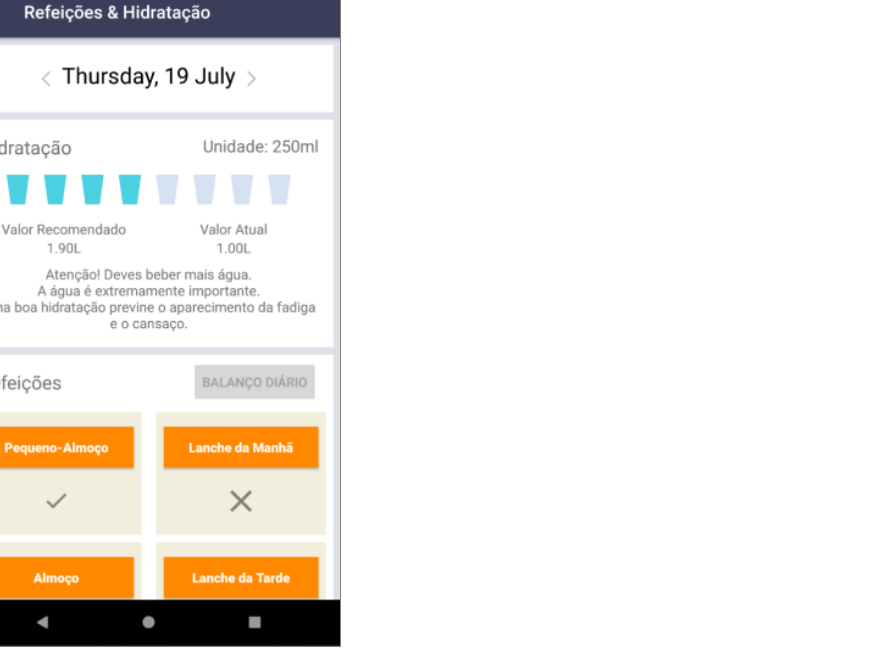
Figure 8. Back button—meals (“refeiç õ es” such as breakfast (“pequeno-almoço”), lunch (“almoço”) and hydration (“hidrataç ã o”) with water intake information and advice—mental model.